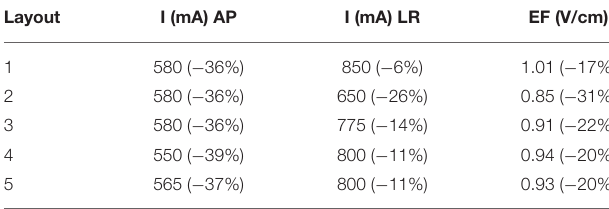
TABLE 3 | Values of the fitted coefficients for the different sets of current injected using layout 3. Injected current (mA) AP/LR